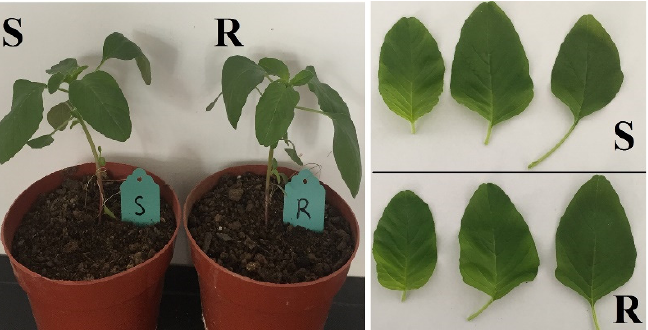
Figure 2. Leaves of ALS-resistant and ALS-susceptible redroot amaranth plants. The sampled leaves were the top three leaves and collected 28 DAT.